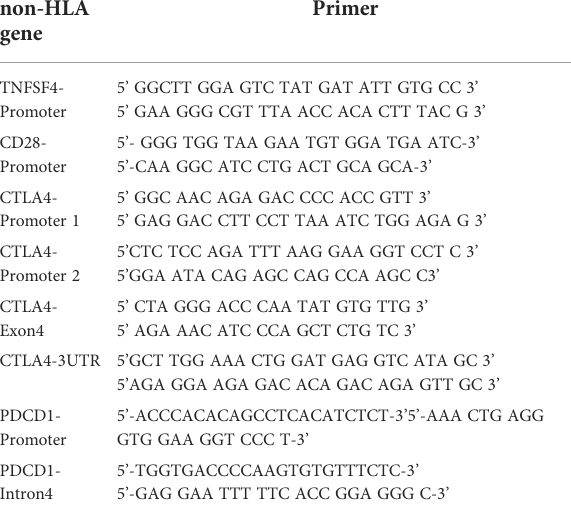
TABLE 1 The pairs of primer for ampli fi cation of candidate